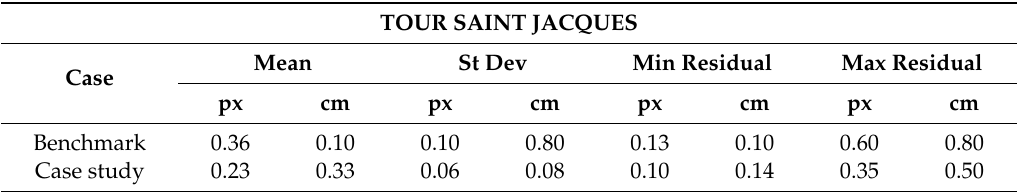
Table 8. Mean, standard deviation, Min and Max values of